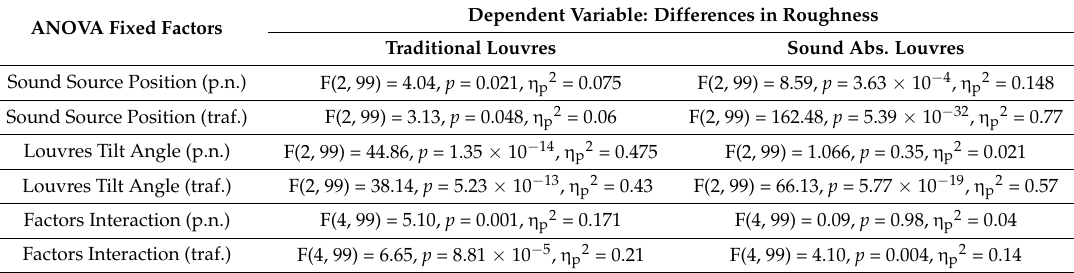
Table A2. Two-way Factorial ANOVAs results referred to the differences in